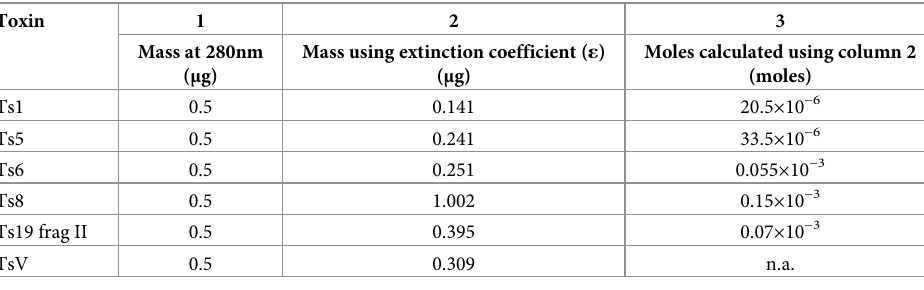
Table 2. T . serrulatus venom and toxins: Mass and molarity used for nociceptive assays.